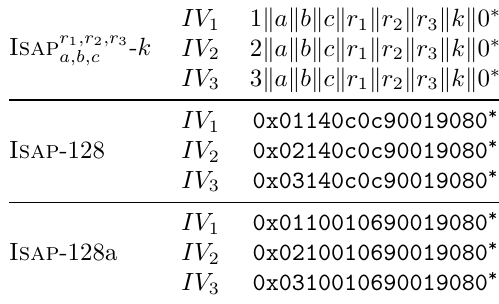
Table 2: Initial values for Isap